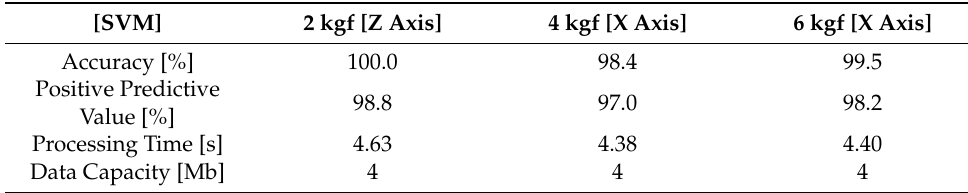
Table 16. Nip force non-uniformity fault diagnosis based on raw data (i.e., Sensors 1, 2, and 3).